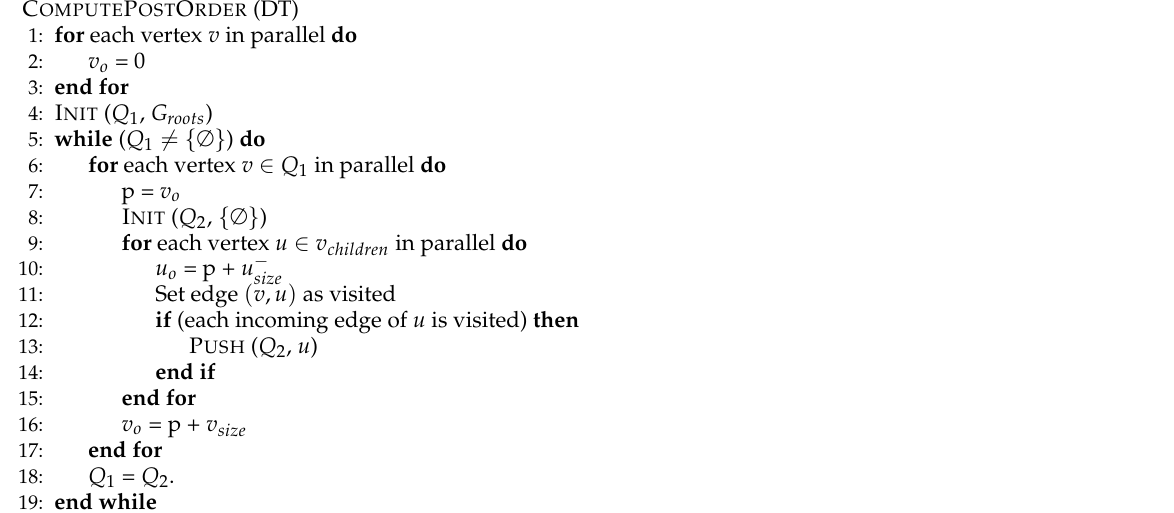
Algorithm 5 Step 3: Post order computation with a top-down BFS.